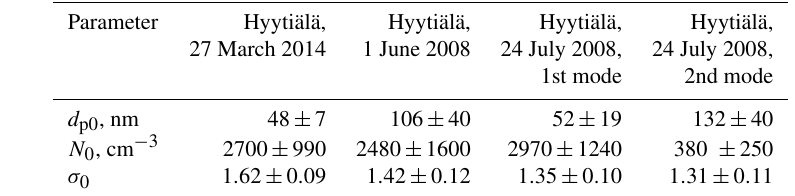
Table 1. Parameters of the lognormal distribution for different days.